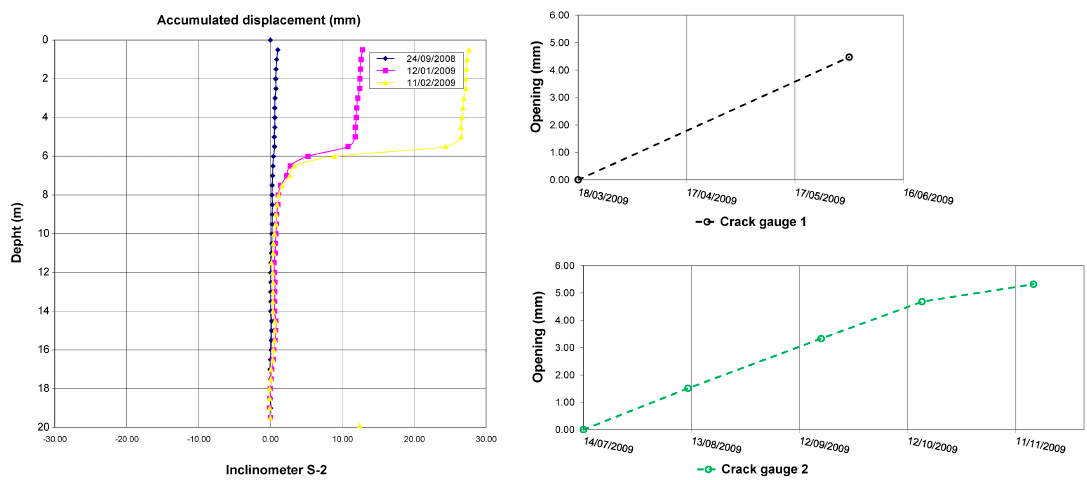
Figure 3. Graphs of the accumulated deformation measured at the inclinometer S-2 (modified from [42]) and maximum opening of cracks measured in the indoor walls of the most damaged building.